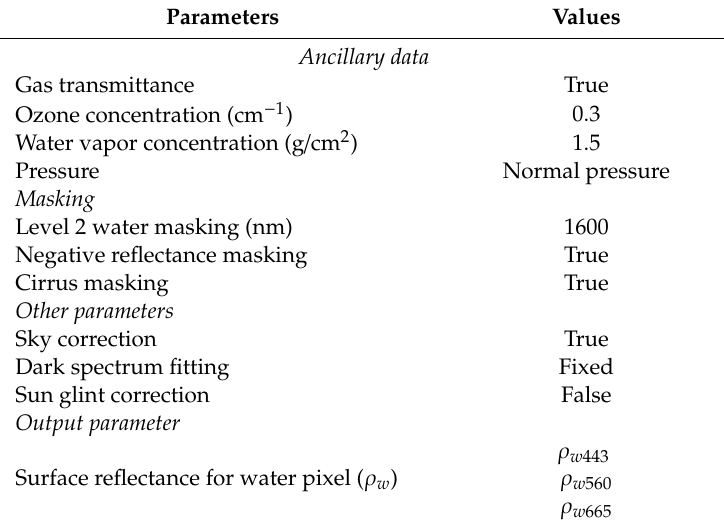
Table 2. Selected parameters for atmospheric correction using